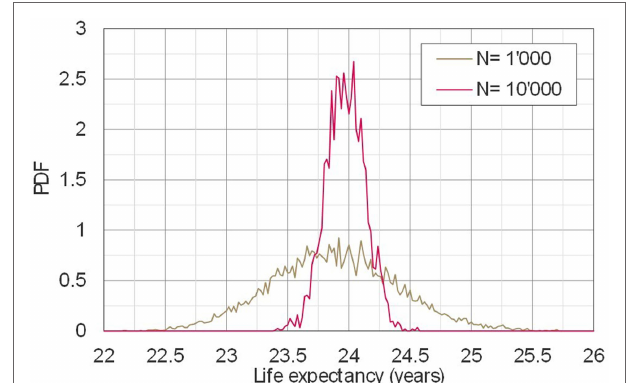
FIGURE 8 | Distributions of life expectancies.